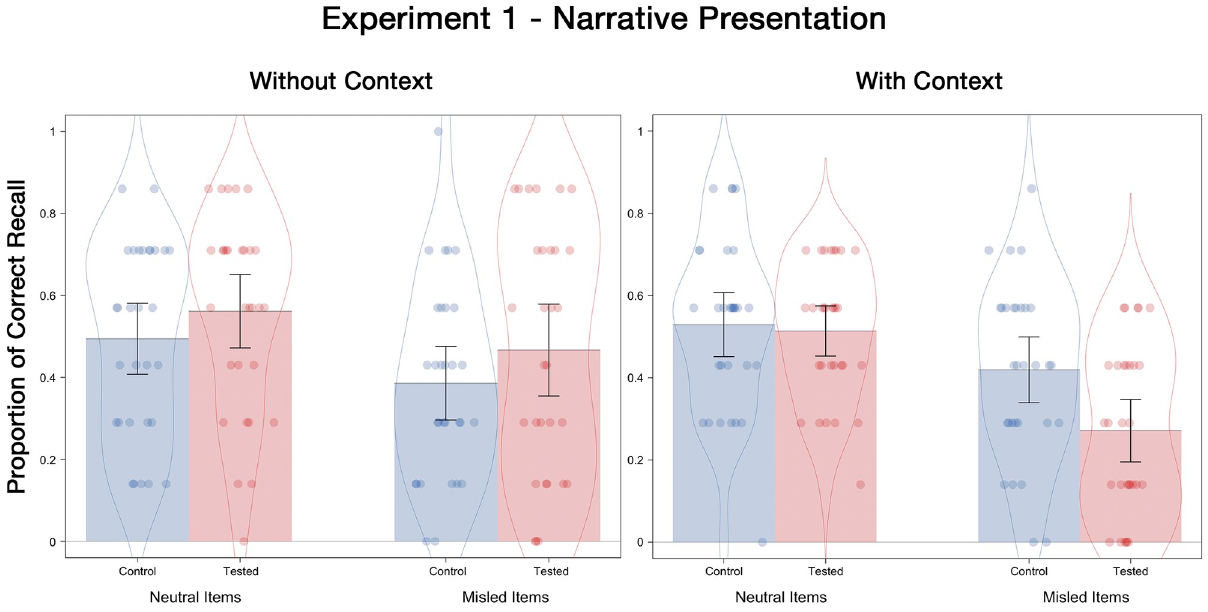
Fig 1. Correct recall probabilities for neutral and misled items as a function of the presence and absence of contextual details on the final test of Experiment 1. Error bars indicate descriptive 95% confidence intervals.